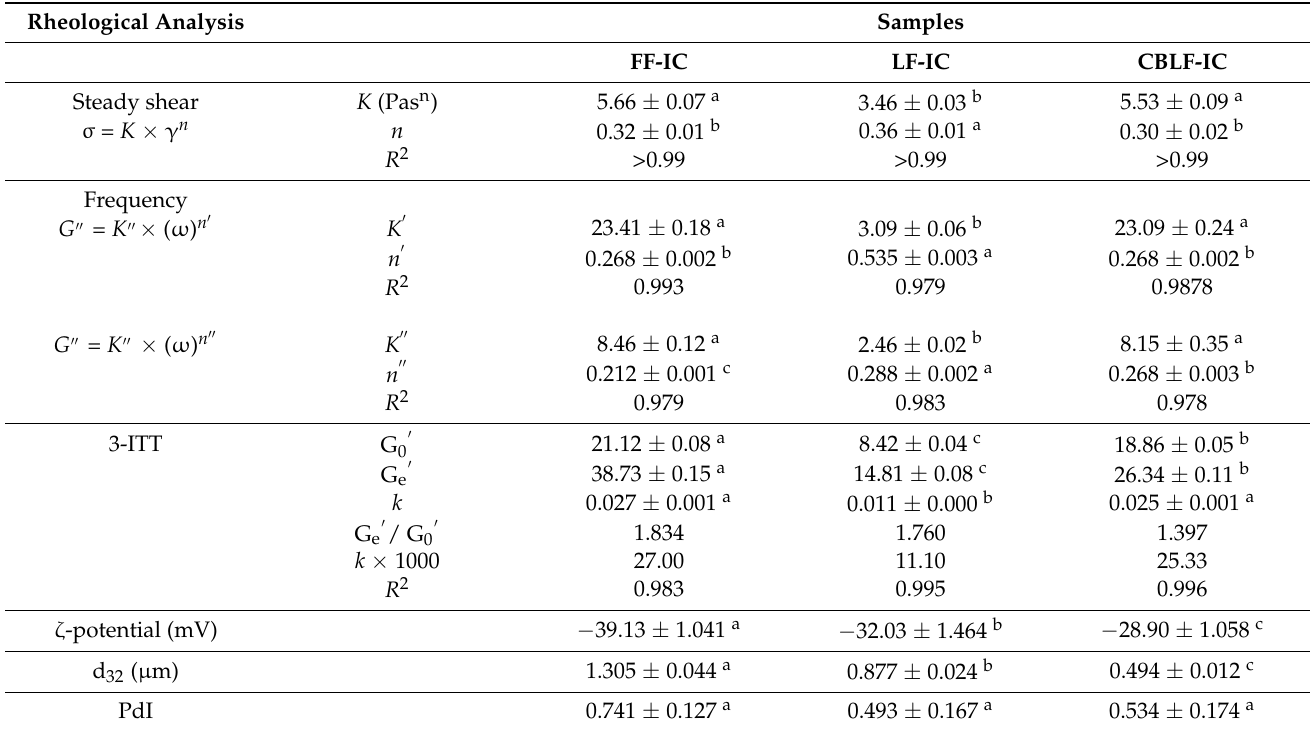
FF-IC: full-fat ice cream, LF-IC: low-fat ice cream, CBLF-IC: low-fat ice cream with chia seed oil by-product. Different lowercase letters in the same line indicate a statistical difference ( p <